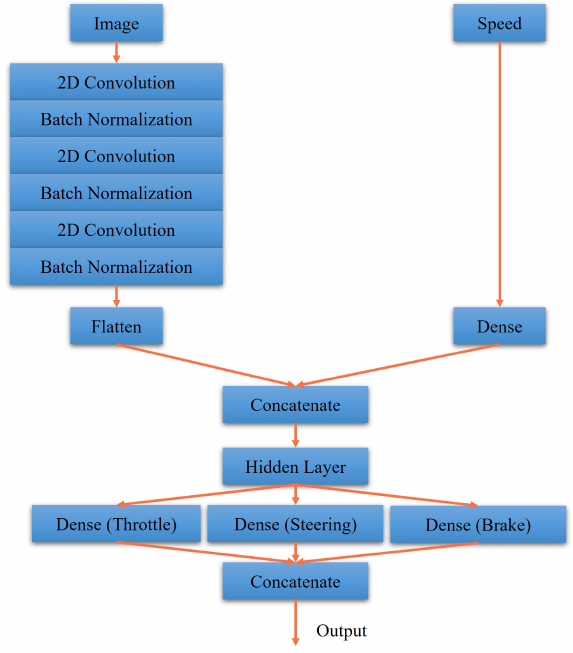
Figure 7. Our actor network for DDPG.